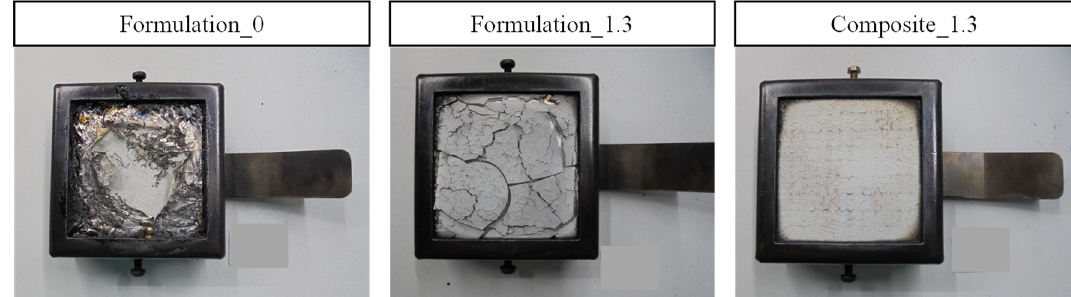
Figure 9. Representative examples for each formulation after smoke density and gas toxicity exper- iments.